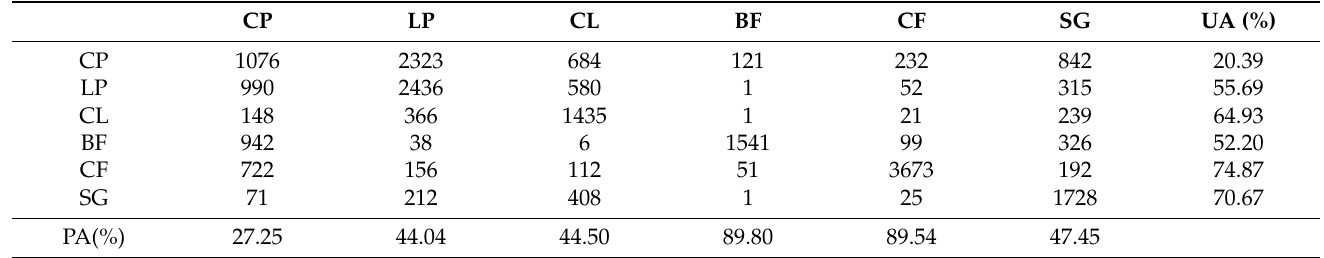
Table 2. Confusion matrix of the classification results of PolSAR data after POA correction.